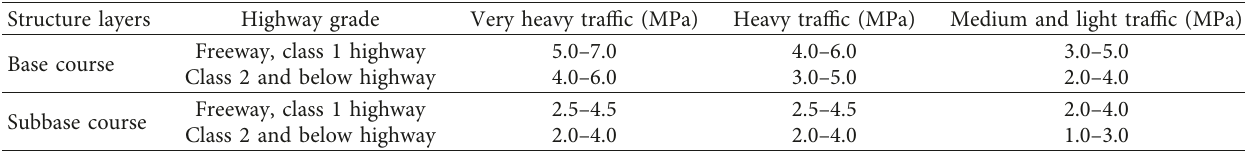
Table 9: UCS standard at 7 days for cement-stabilized